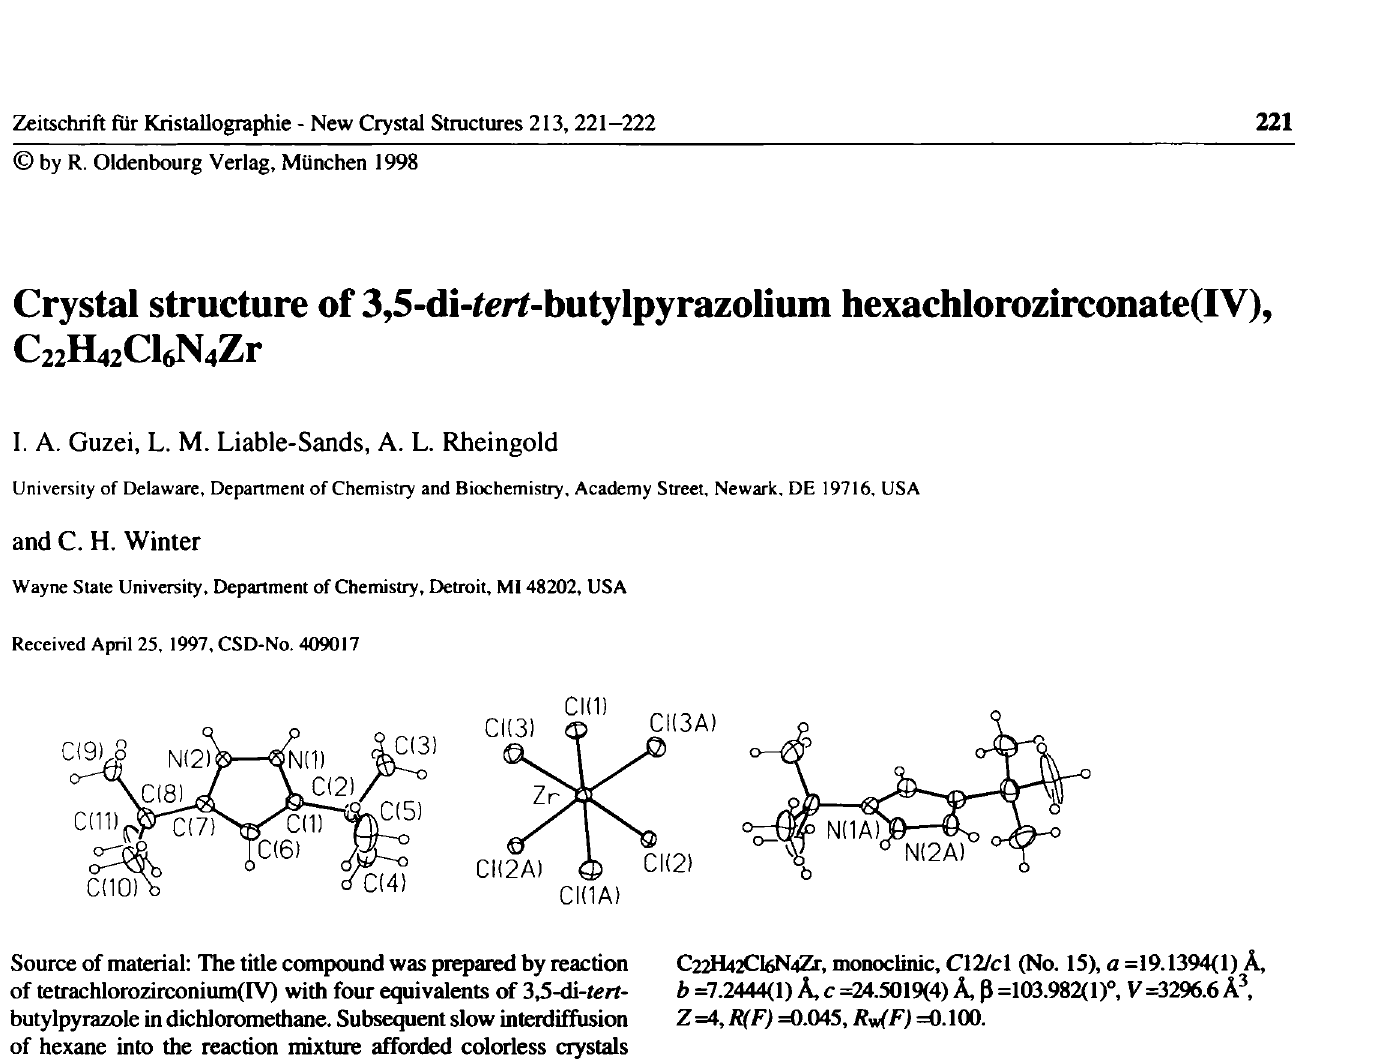
Table 2. Final atomic coofxlinates and displacement parameters (in Â^)